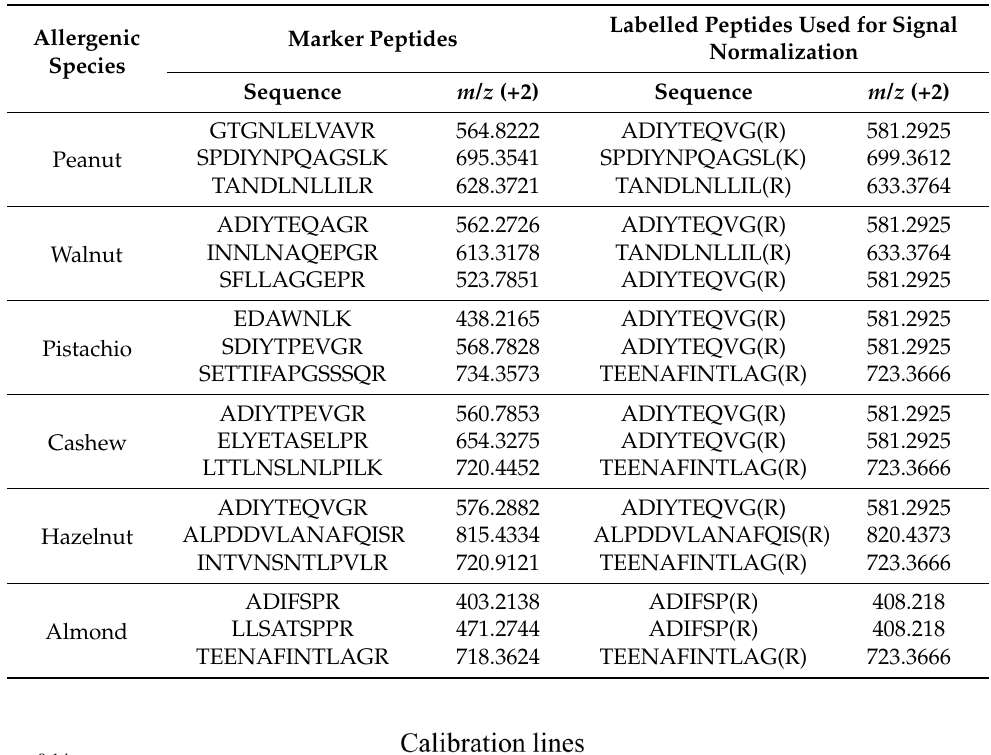
Table 3. Correspondence between marker peptides selected for nuts and peanuts and isotopically labelled peptides used for the normalization of XIC peak areas.